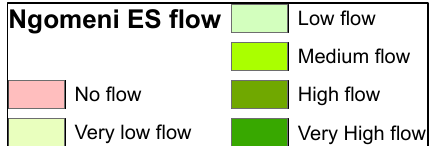
Figure 6. The spatial distribution of ES flow for provisioning, regulating, supporting, and cultural services provided in Ngomeni (Ungwana bay, Kenya).